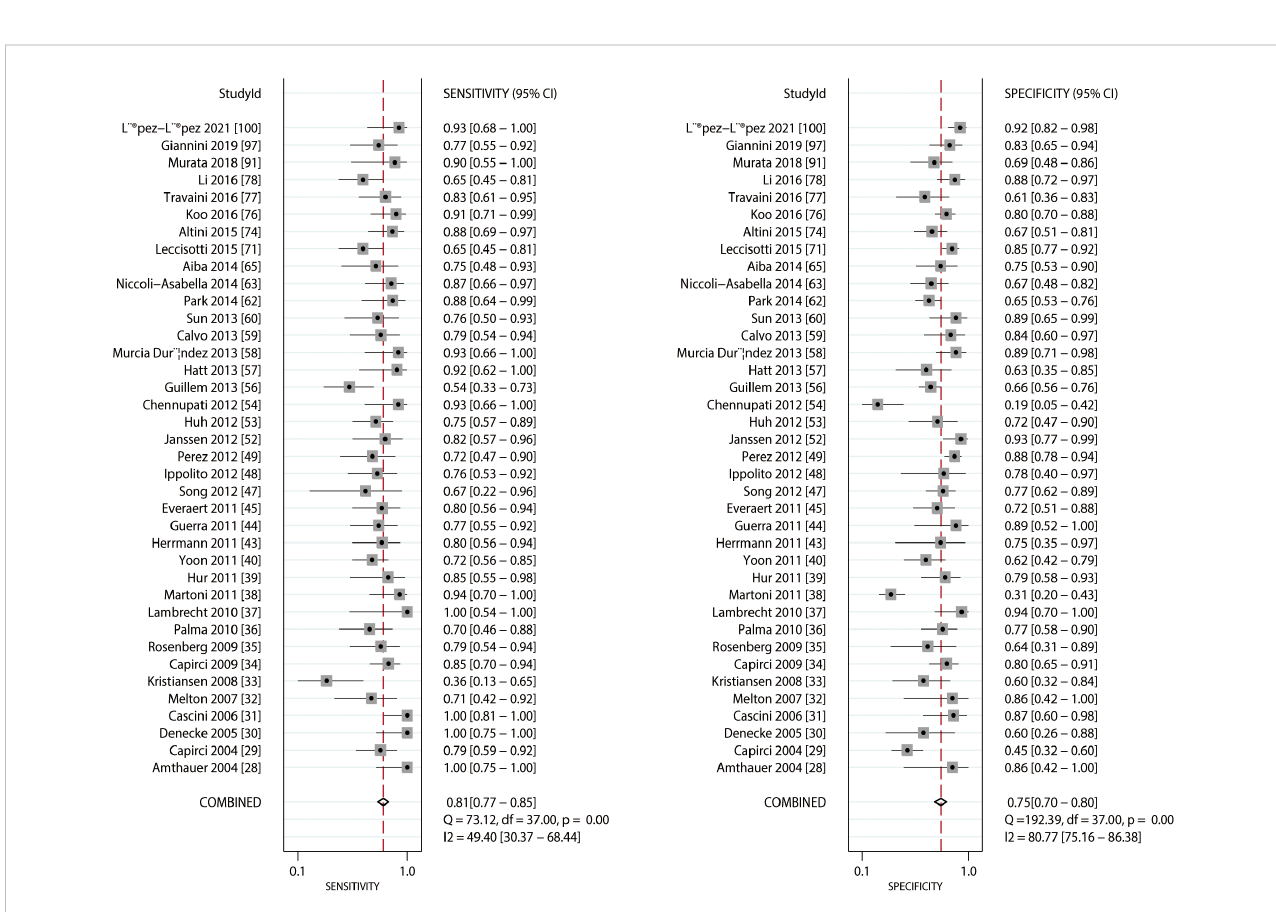
FIGURE 6 Pooled sensitivity and speci fi city of FDG-PET and